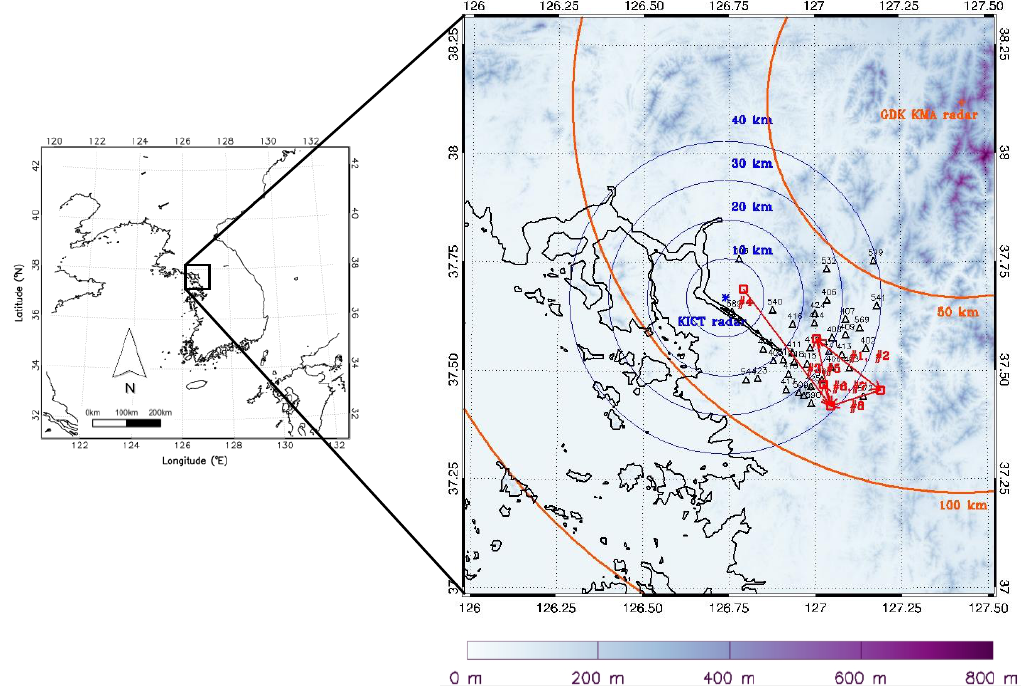
Figure 1. Location of research area (Seoul) in Korea. Red lines represent microwave links, the orange asterisk symbol represents the Gwangdeoksan (GDK) radar, the blue asterisk represents the Korea Institute of Civil Engineering and Building Technology (KICT) radar, and the black triangles indicate automatic weather stations (AWS) locations.